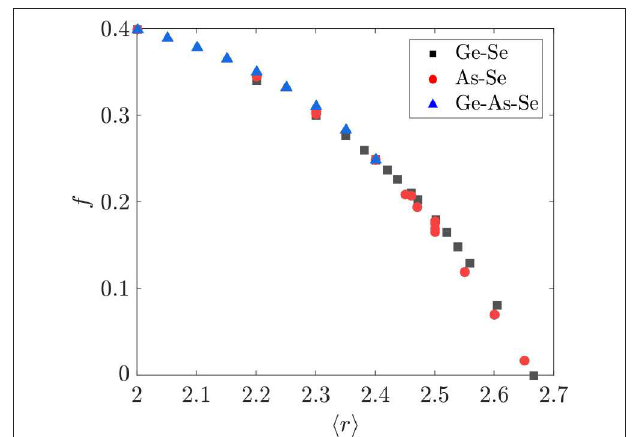
FIGURE 6 | Fractional degrees of freedom f as a function of average coordination number h r i . Composition ranges for the various systems